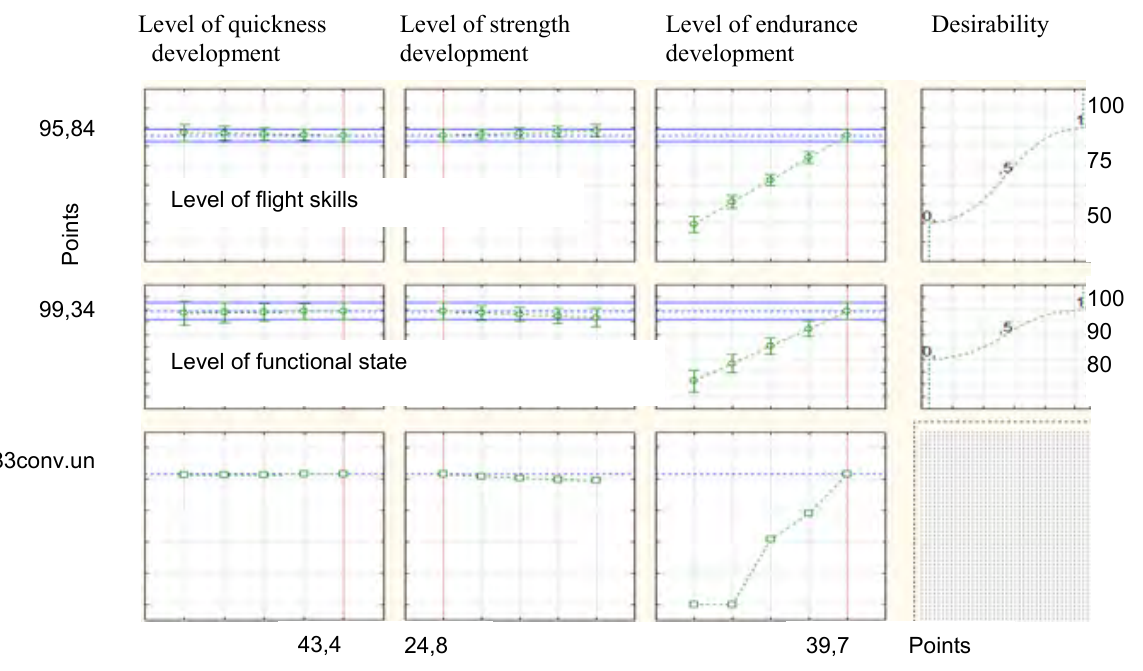
Fig.1. Optimal profile of development of general physical abilities, which are necessary for achievement of high level flight skills, with maintaining of cadets’ appropriate functional state